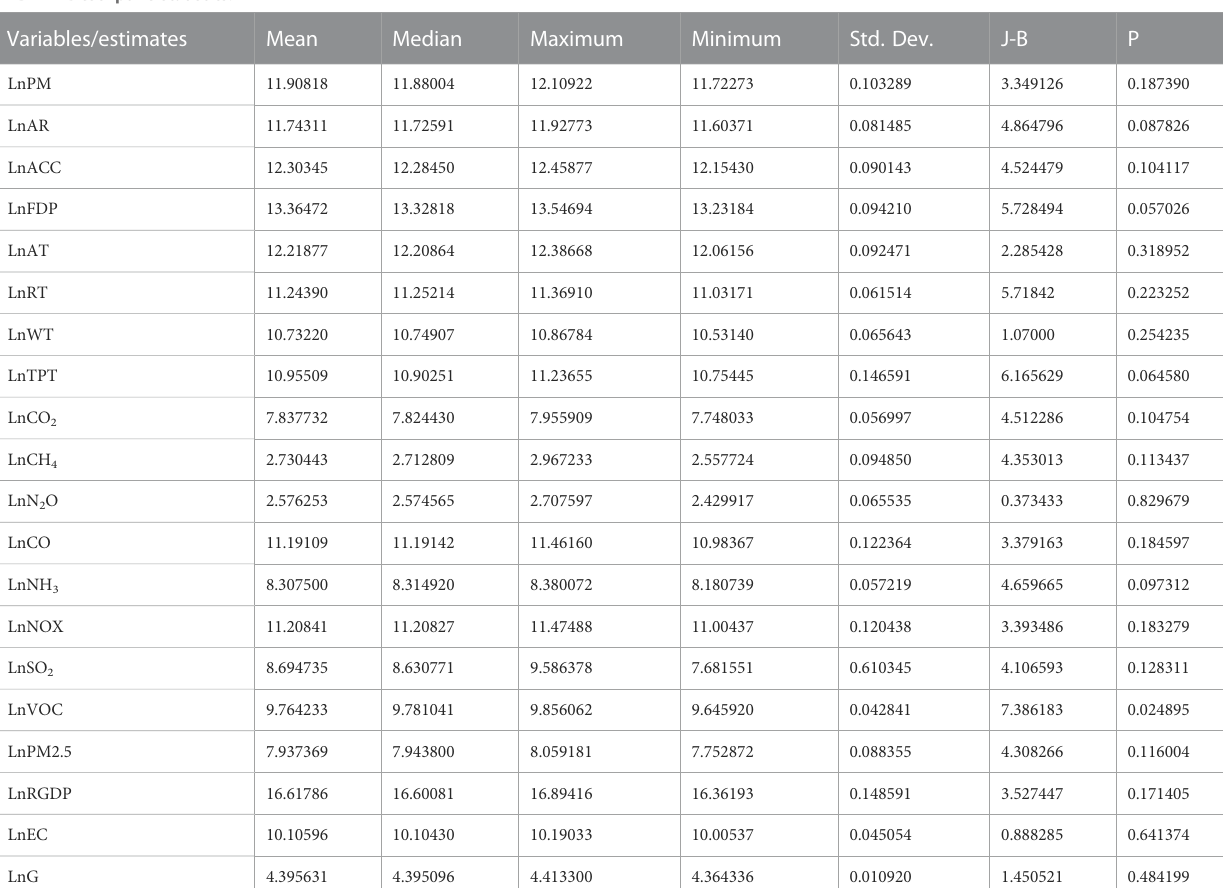
TABLE 2 Descriptive statistics.